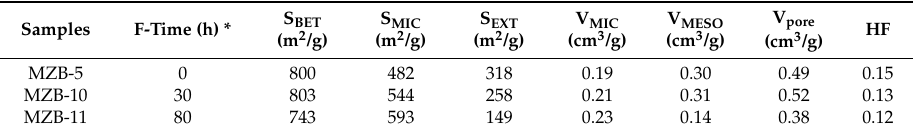
Table 3. Pore structure parameters of hierarchical Beta zeolites with different recrystallization time. Samples